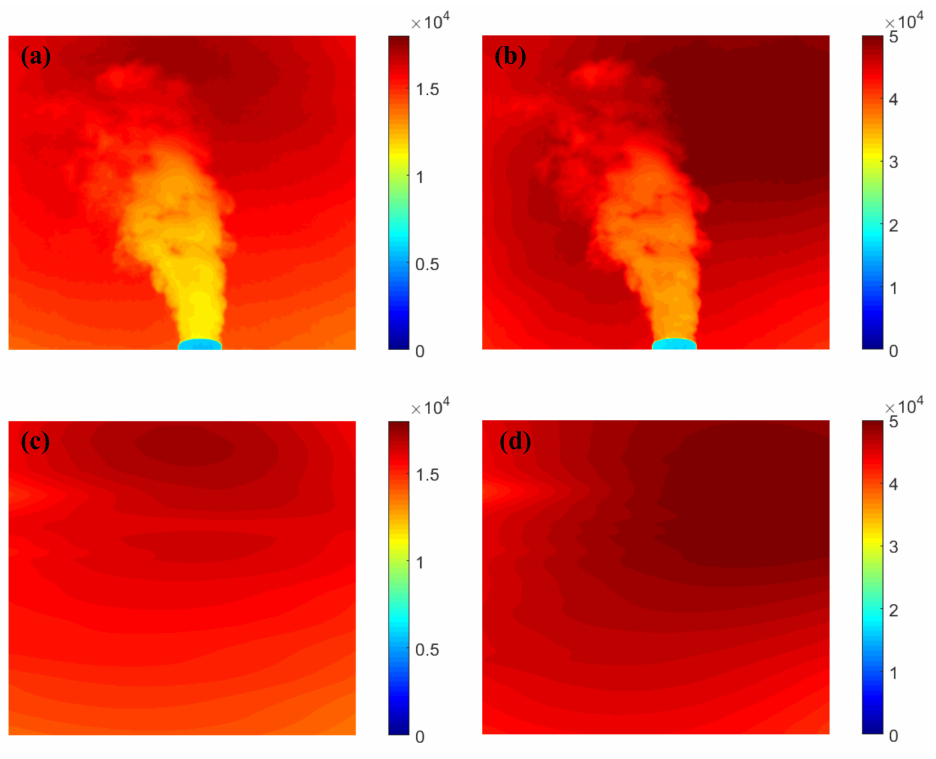
Figure 4. Example of raw images at λ on = 310 nm ( a ); and at λ of f = 330 nm ( b ); and the artificial background sky images at λ on = 310 nm ( c ); and at λ of f = 330 nm ( d ).